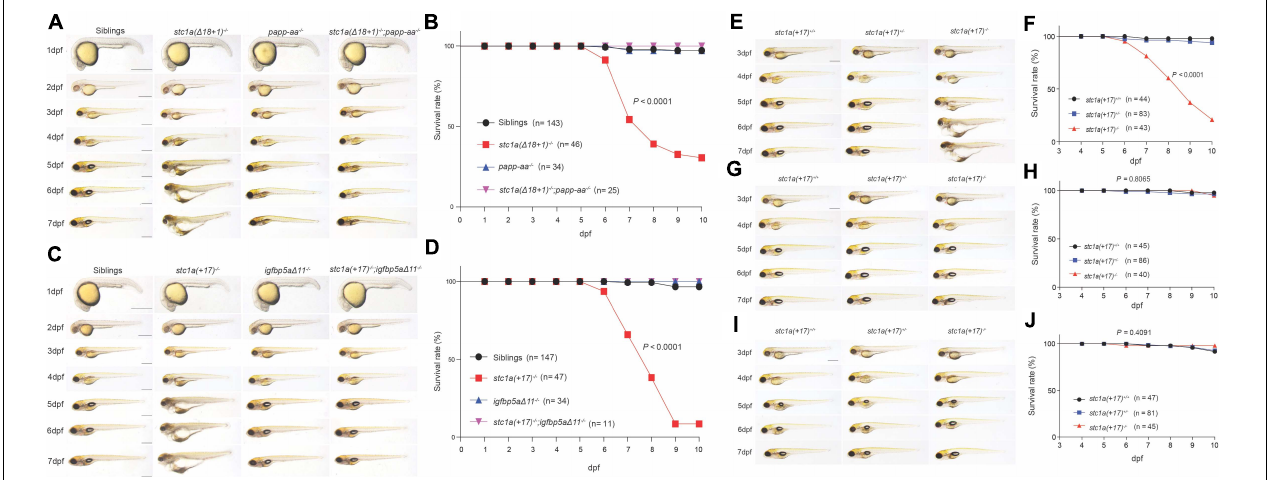
FIGURE 6 | Perturbation of the Papp-aa-Igfbp-a-IGF signaling loop rescues the body edema and premature death in stc1a - / - fish. (A,C) Gross morphology of fish of the indicated genotypes at the indicated stages. Lateral views with anterior to the left and dorsal up. Scale bar = 0.5 mm. (B,D) Survival curves. Embryos were raised in E3 embryo medium. Dead embryos were collected daily and genotyped individually. The survival curves of indicated genotypes and the total fish numbers are shown. P < 0.0001 by log-rank test. (E–J) Progeny of stc1a ( + 17) + / − intercrosses were raised in E3 embryo media containing DMSO (E,F) , 0.3 µ M BMS-754807 (G,H) or 5 µ M Rapamycin (I,J) starting from 3 dpf until the indicated time. Representative morphological views of the indicated genotypes at the indicated stages are shown in (E,G,I) . Scale bar = 0.5 mm. P < 0.0001 by log-rank test. Dead fish were collected daily and genotyped individually. The survival curves of the indicated genotypes and the total fish numbers are shown in (F,H,J) .